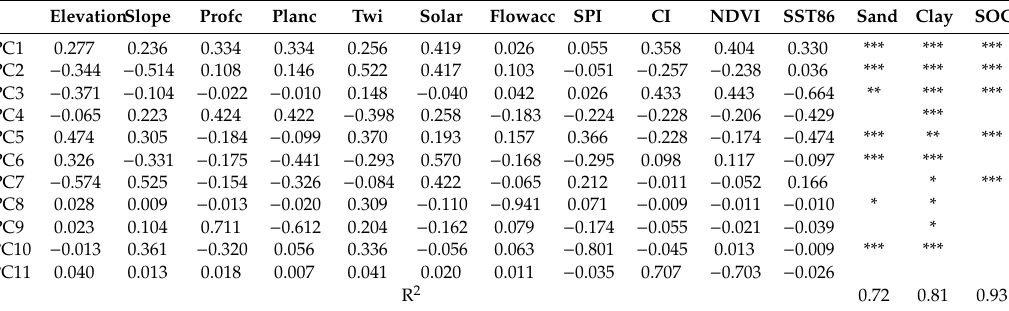
Table 2. Matrix of principal components coe ffi cients and their significance for prediction. ElevationSlope Profc